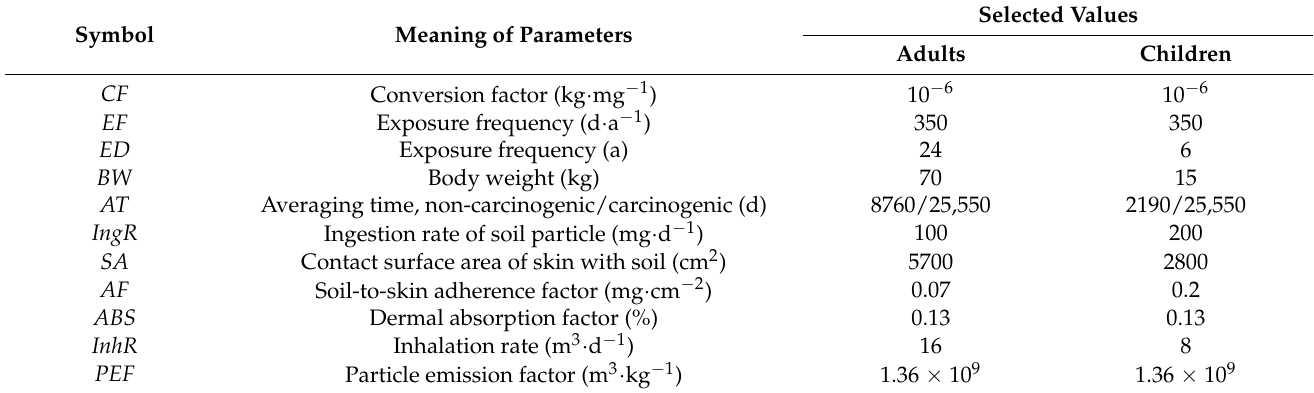
Table 1. Exposure evaluation parameter